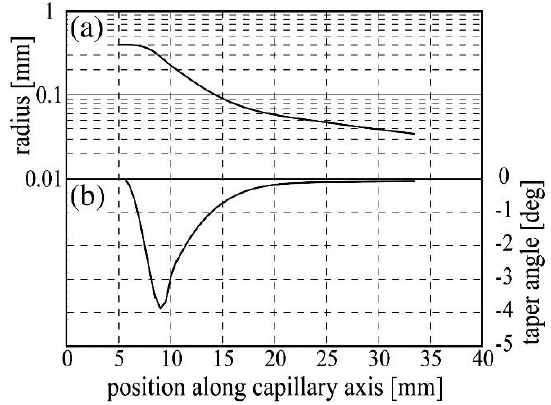
Figure 8. ( a ) Capillary inner radius measured as a function of the position along the axis and ( b ) extracted taper angle from (a) (from [10], Copyright 2011, with permission from Elsevier).